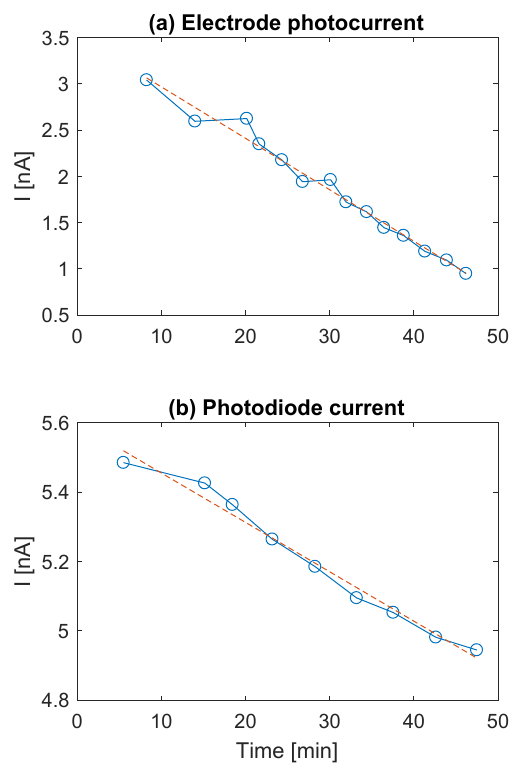
Figure 16. Decrease of (a) the electrode photocurrent and (b) the photodiode current over time, suggesting a degradation of the UV throughput due to contamination on the Lyman-alpha filter. Time starts at the start-up of the light source. The red dashed line shows a linear fitting.